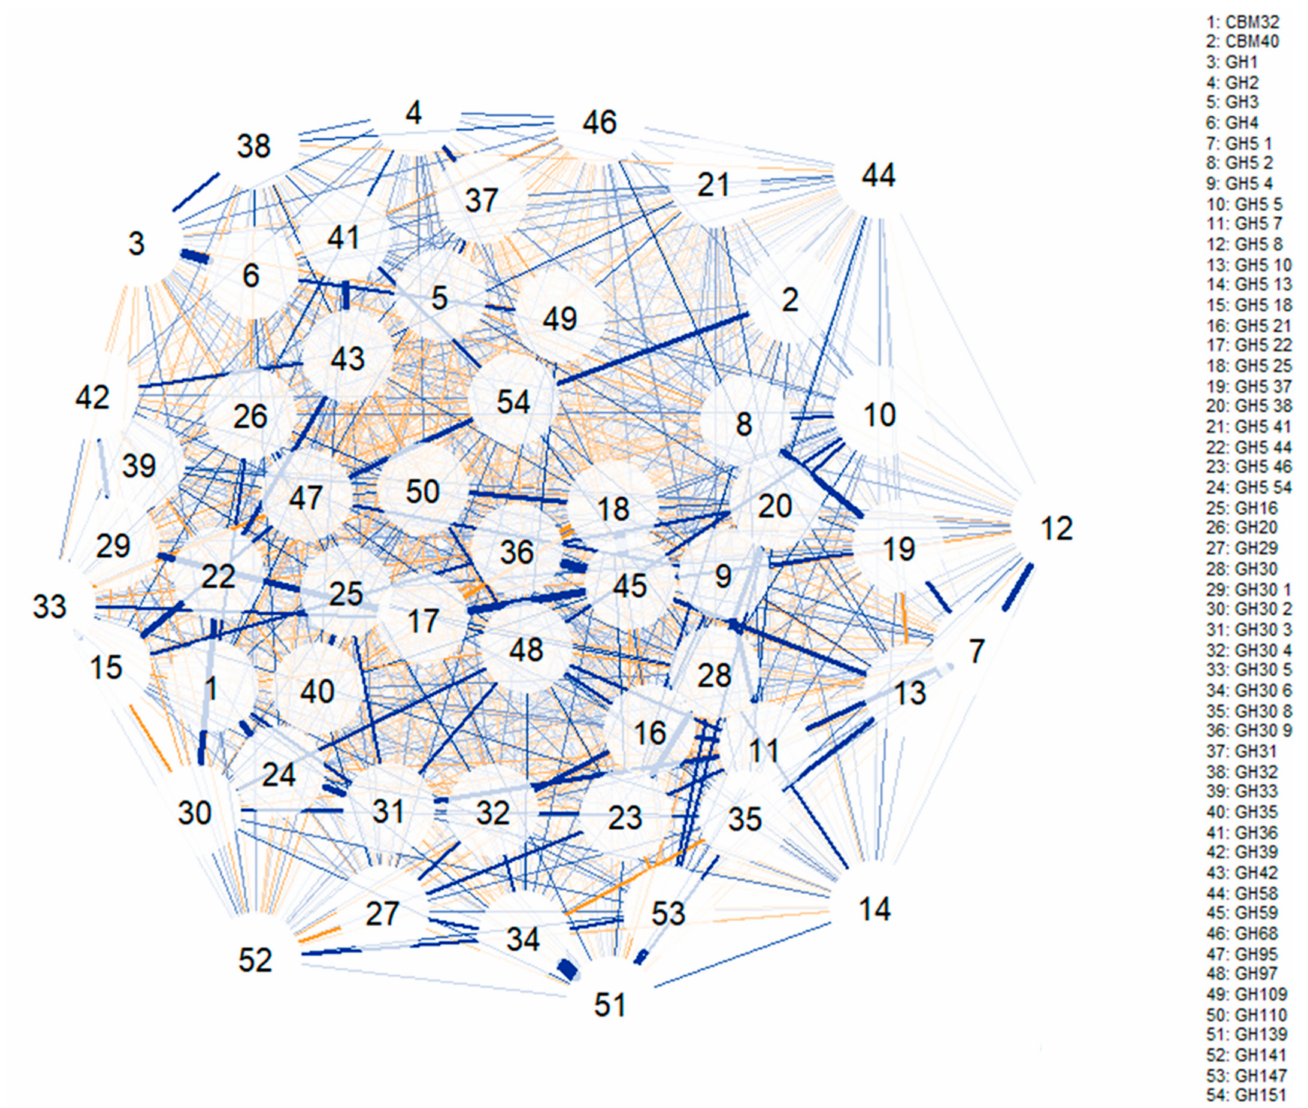
Figure 4. Correlation network illustrating positive and negative associations between glycosidase activities capable of degrading galacto- and fructo-oligosaccharides (GOS and FOS) as well as human milk oligosaccharides (HMOs), encoded in metagenome-assembled genomes (MAGs) from all species identified (bifidobacteria or not). Blue lines indicate positive associations, while saffron lines suggest negative associations. Line thickness is in proportion to magnitude. Specific activities included in each glycosidase family can be found in Supplementary Materials Table